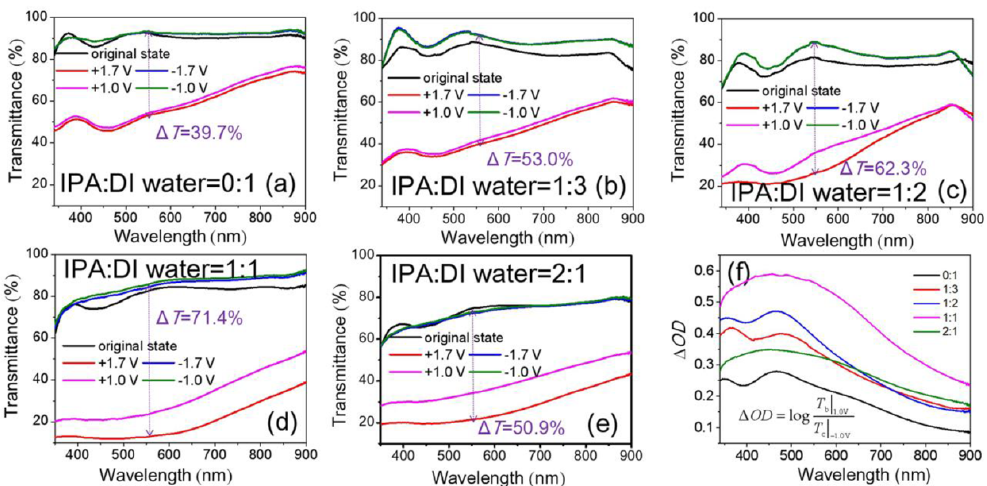
Figure 7. Optical transmittance spectra at as-deposited, colored and bleached states of NiO x films as a function of the volume ratios of IPA:DI water in NiO x inks: ( a ) 0:1; ( b ) 1:3; ( c ) 1:2; ( d ) 1:1 and ( e ) 2:1 (The increases of voltage has little effect on the T b , so the 2 bleached curves overlap together) and ( f ) Δ OD . The NiO x thin films are by spin-coating three times and after 150 °C annealing.